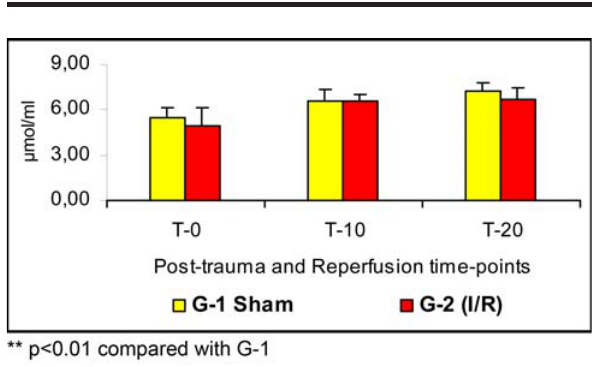
FIGURE 7 - Blood lactate concentrations (n=6) in G-1 and G-2 rats. Values are expressed as